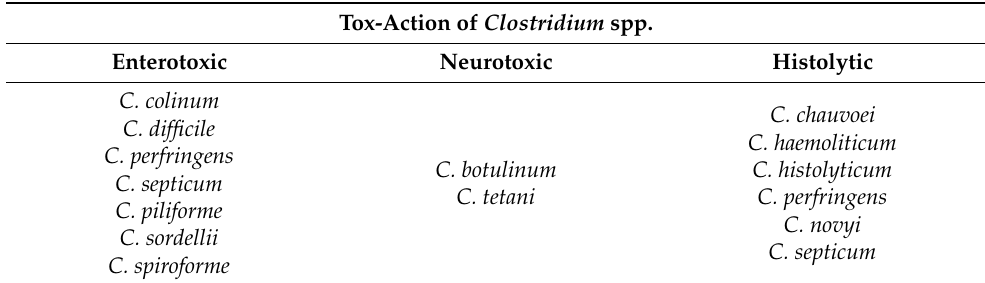
Table 1. Classification of pathogenic Clostridium spp. according to the toxins’ target. Tox-Action of Clostridium